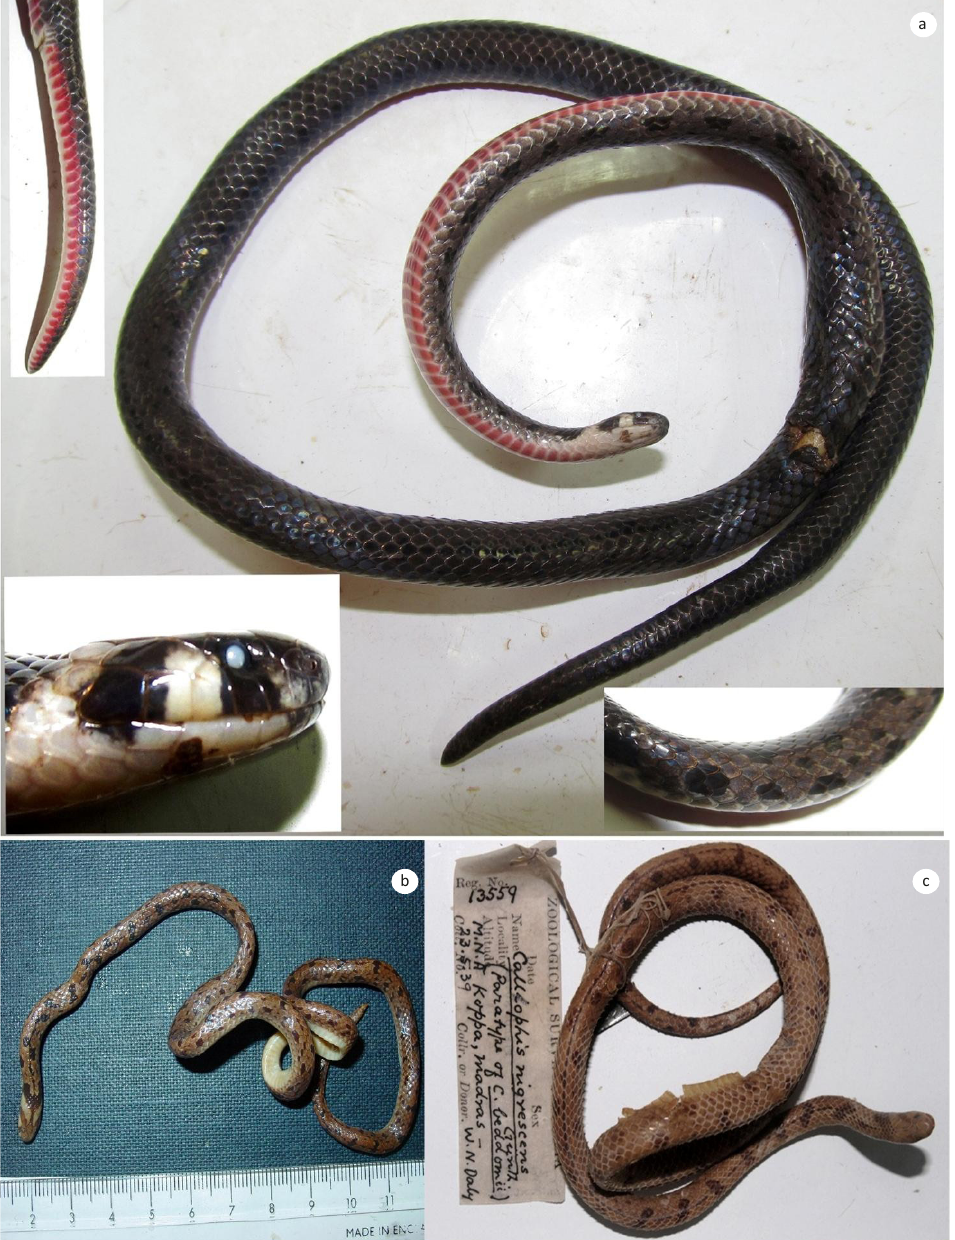
Image 1. (a) Calliophis beddomei non type CSPT/S-82; insets showing closeup of lateral view of head, midbody and ventral view of tail; (b) holotype BMNH 1946.1.17.99 (Photo: ColinMcCarthy); (c) paratype ZSIC 13559 (Photo: S.R. Chandramouli).